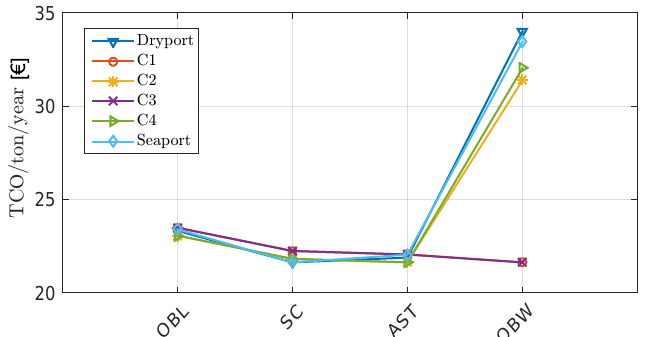
Figure 16. Sensitivity of annual cost incurred per unit freight with regard to different loading– unloading schemes, i.e., On-Board Lift (OBL), Straddle Carrier (SC), Additional SemiTrailer (AST) On-Board vehicle Waiting (OBW) on the first